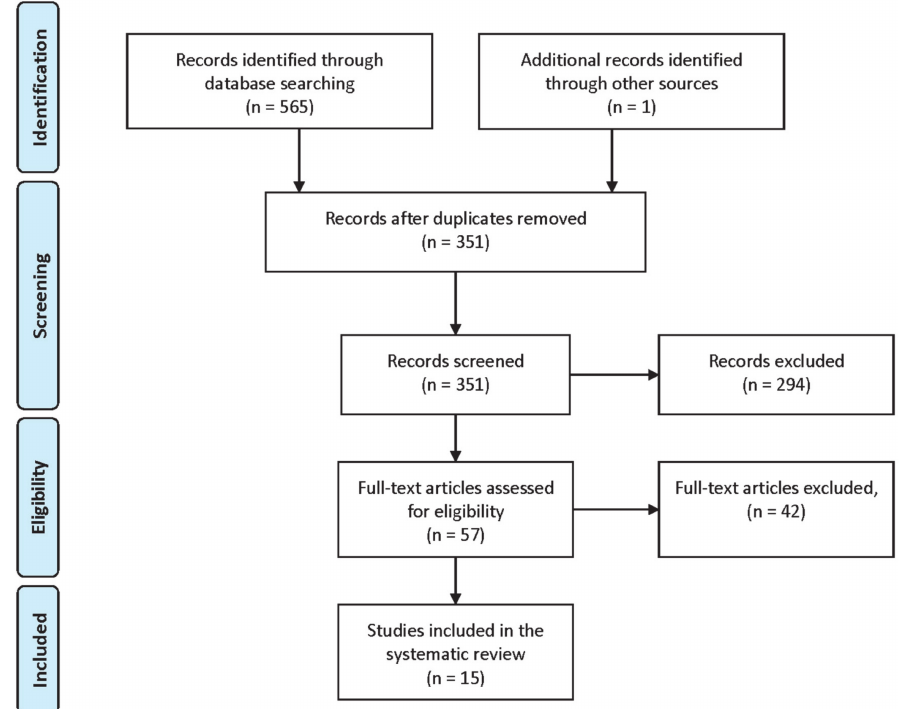
Figure 2. Flow diagram of the study retrieval process.